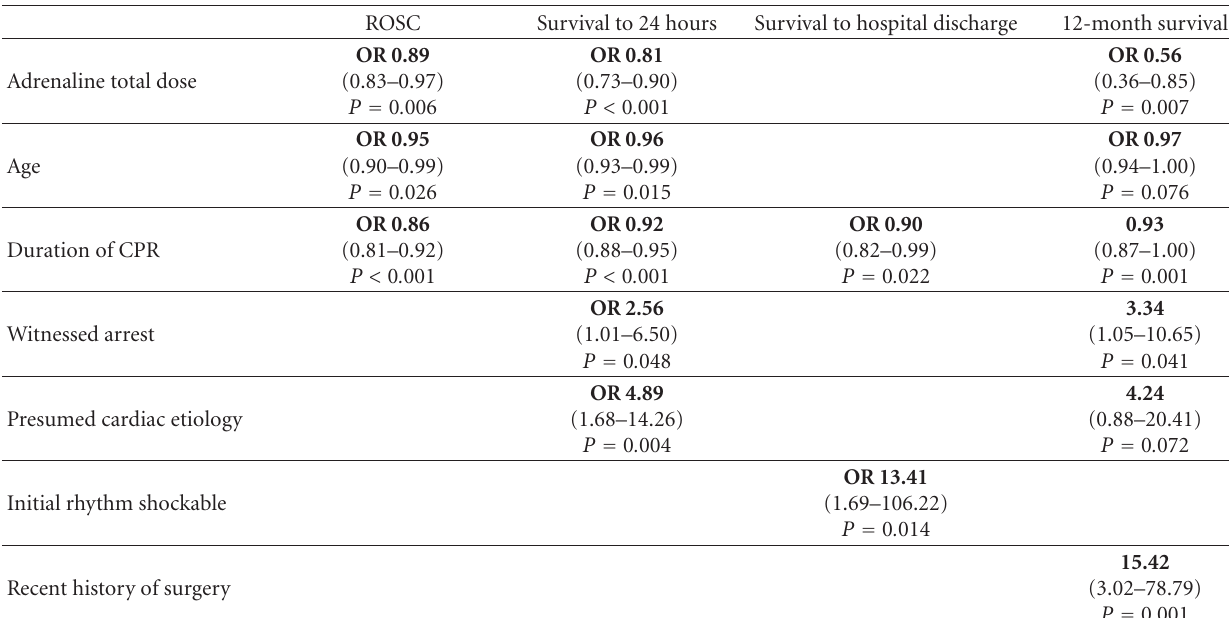
Table 2: Multivariable logistic regression models for survival.